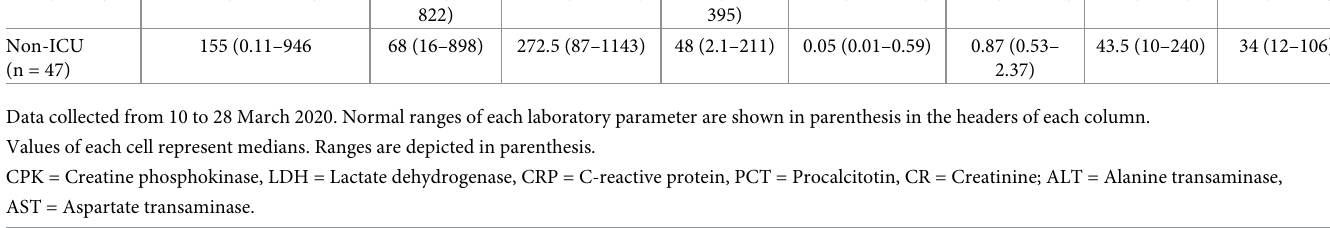
Table 2. Blood chemical values for laboratory-confirmed COVID-19 cases (n = 61) by Intensive Care Unit (ICU) admission status in the Hospital General del Sur de Quito (HGSQ), Quito, Ecuador—March 2020. ICU/Non-ICU